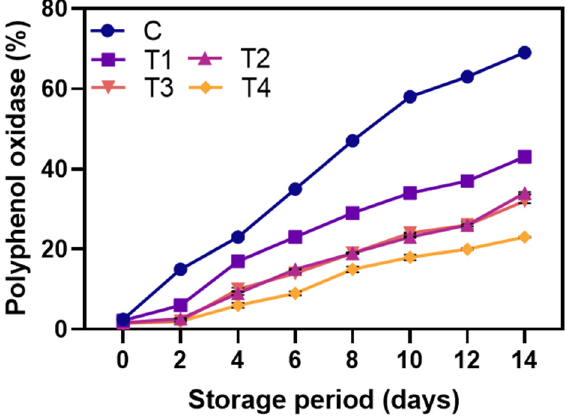
Figure 5. Changes in polyphenol oxidase of the shrimps coated with different coatings during storage of 14 days at 4 °C. C: shrimp dipped in distilled water as control; T1: shrimp coated with alginate coating; T2, T3, and T4: shrimp coated with 0.5, 1.0, and 1.5% LPE, respectively.